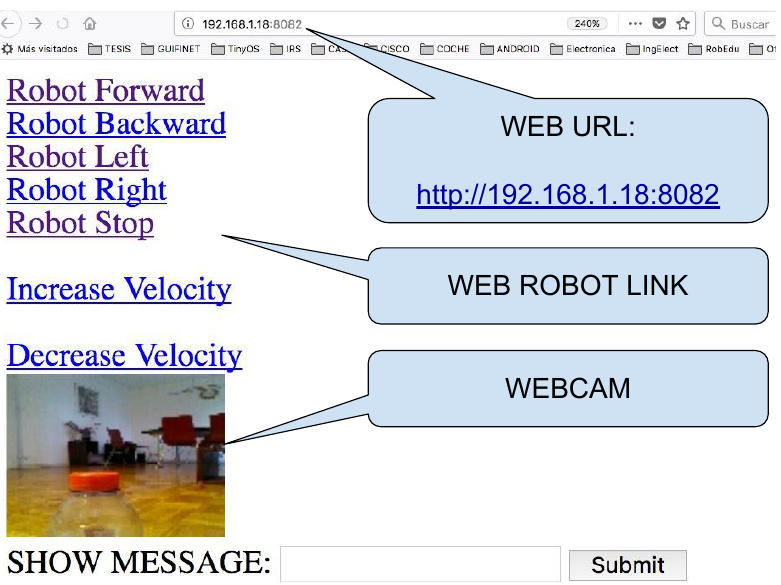
Figure 20. Web user interface to the remote robot, by showing an HTML file that is served from the onboard Android device Application running at IP (192.168.1.18) and port (8082), by using the